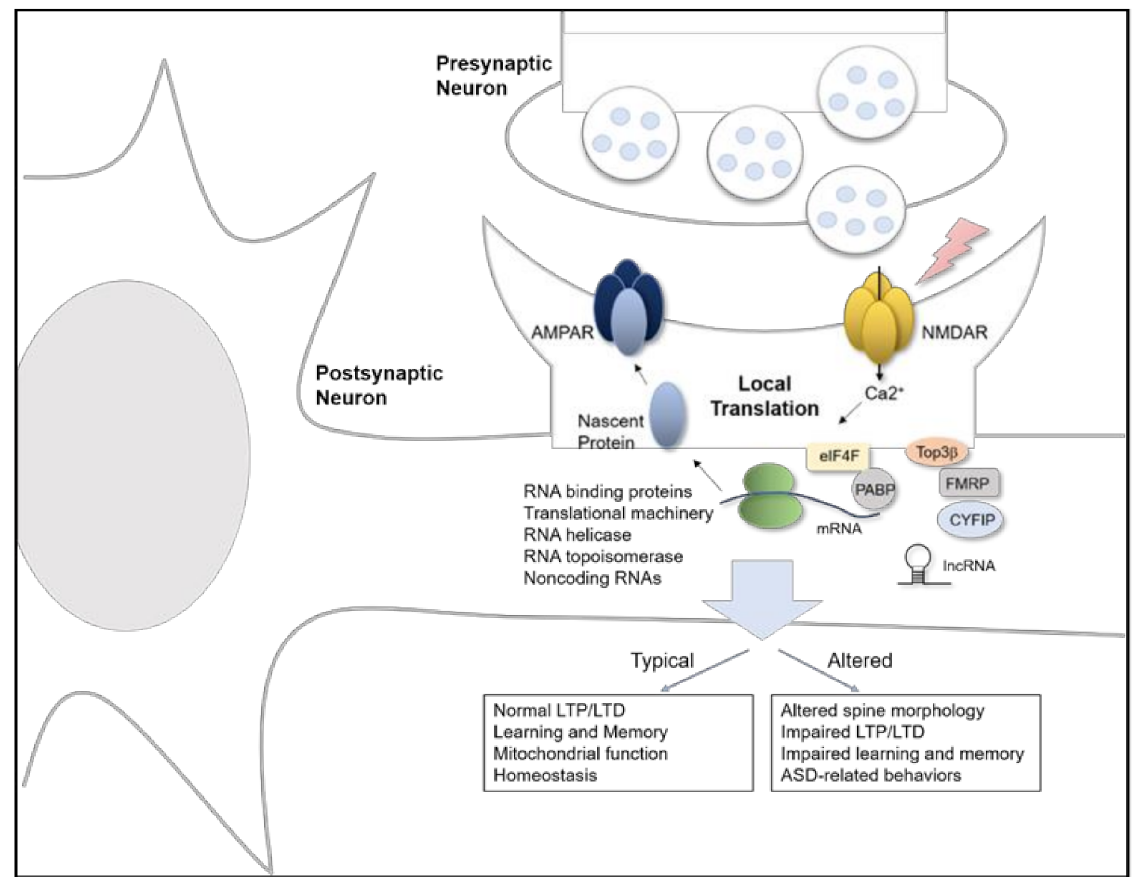
Figure 1. Schematic model of local protein translation and RNA processing of synaptic proteins in